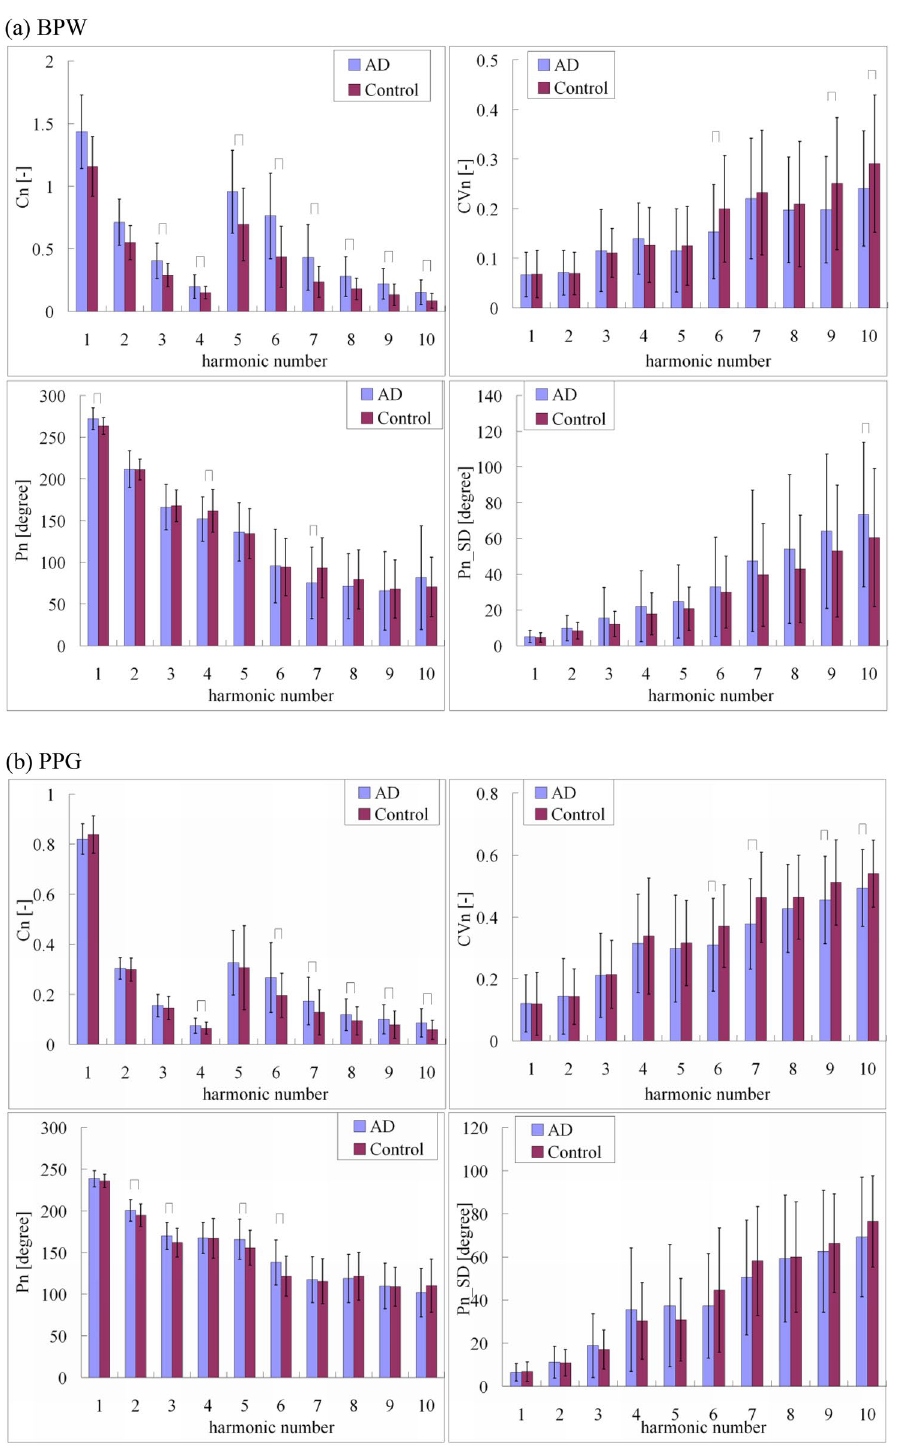
Figure 2. Comparisons of ( a ) BPW and ( b ) PPG harmonic indices between AD patients and control subjects: C n , CV n , P n , and P n _ SD . Data are mean and standard-deviation values. C 5 – C 10 values have been multiplied by 5 to make the differences clearer. “ ⌢ ” indicates p < 0.05. In BPW indices, C 3 – C 10 , P 1 , and P 10 _ SD were significantly larger and CV 6 , CV 9 , CV 10 , P 4 , and P 7 were significantly smaller in AD patients than the control subjects. In PPG indices, C 4 , C 6 – C 10 , P 2 , P 3 , P 5 , and P 6 were significantly larger and CV 6 , CV 7 , CV 9 , and CV 10 were significantly smaller in AD patients than the control